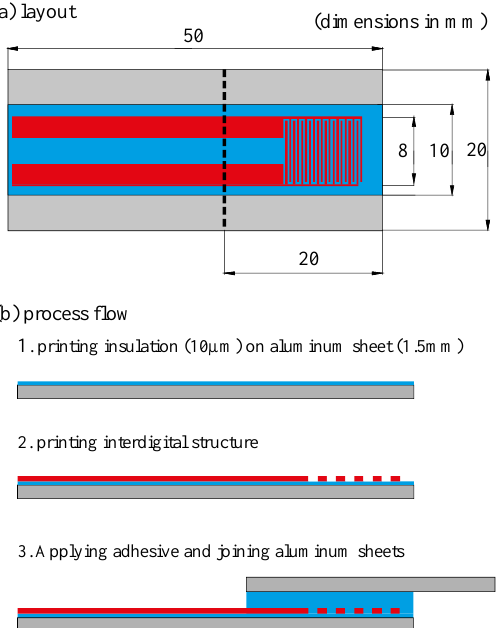
Figure 2. Sensor layout and process flow of the printed interdigital structure on aluminium